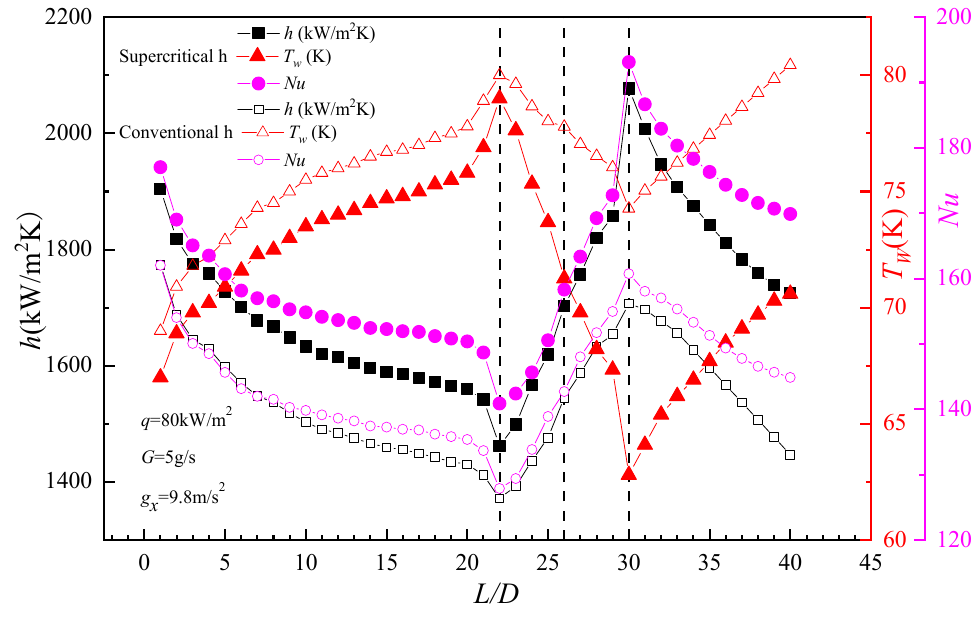
Figure 8. Variation of T w , h and Nu with L/D .